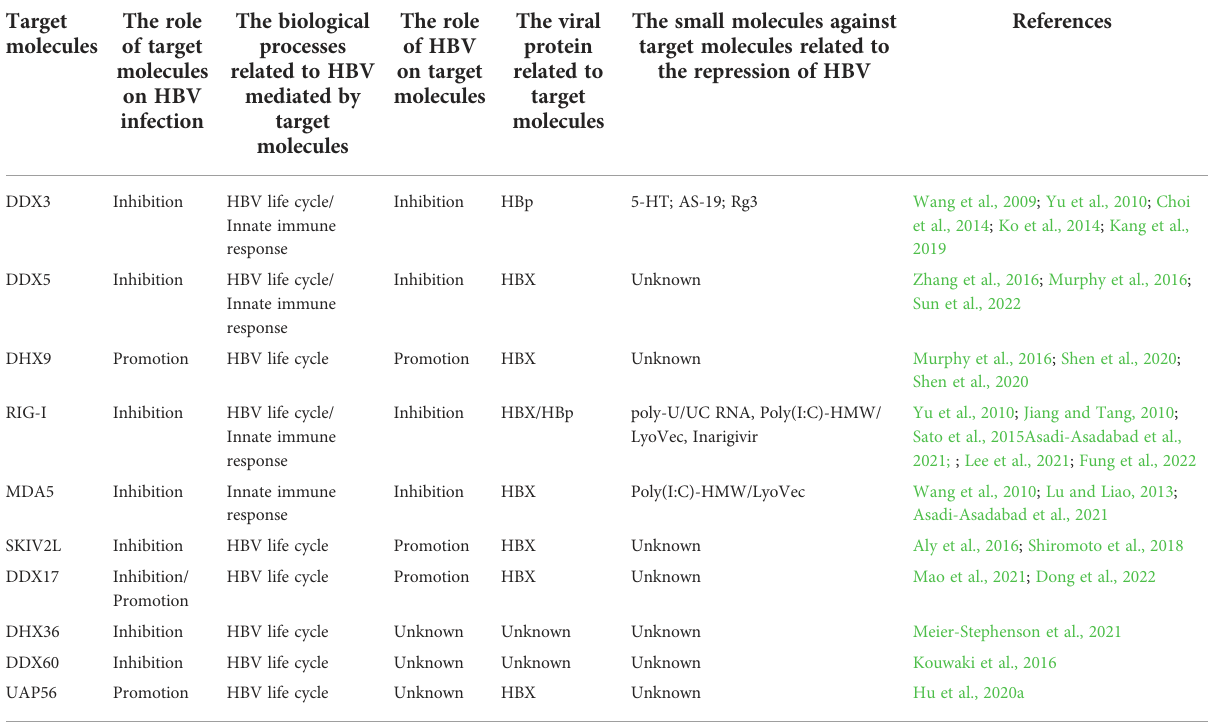
TABLE 1 The detailed information on the interaction between HBV and DEAD/H-box